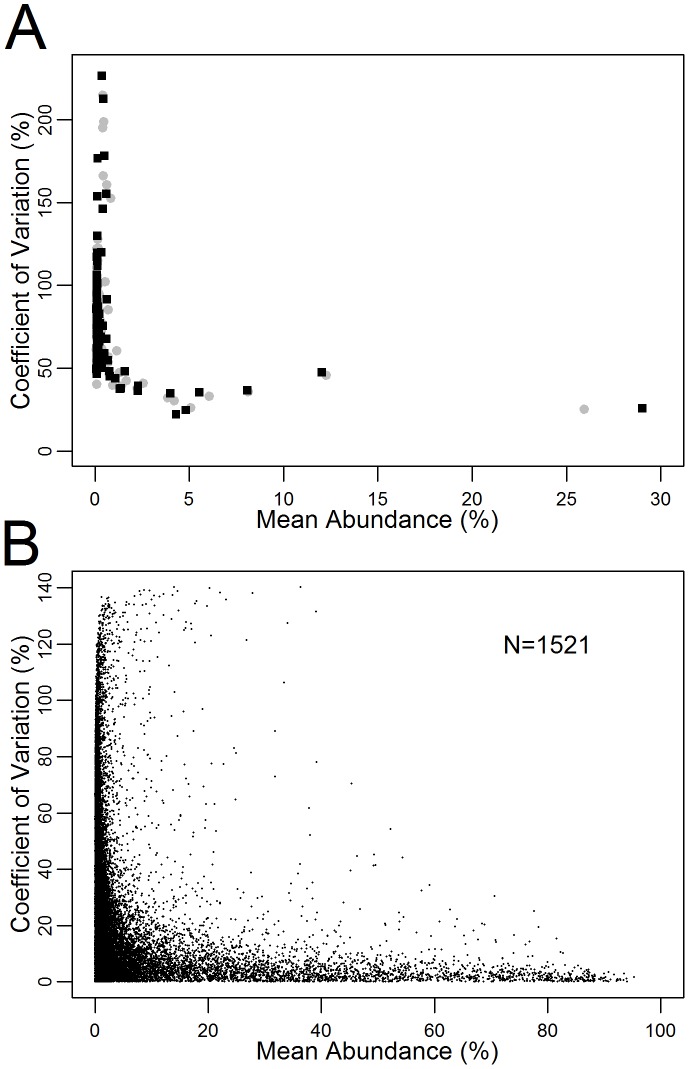
Variability as a function of sequence abundance.The forward direction is indicated in black, the reverse direction in grey. A) Variability in the 100 most common sequences from a non-homogeneous clinical sample run multiple times (N = 47 replicates over 18 deep sequencing runs). B) Variability between the forward and reverse direction for samples in MOTIVATE/A4001029 dataset (N = 1521 samples; 41030 unique sequences, median 26 [IQR 19–34] per sample). Less abundant sequences tended to have more variable prevalence estimates in comparison to more abundant sequences.